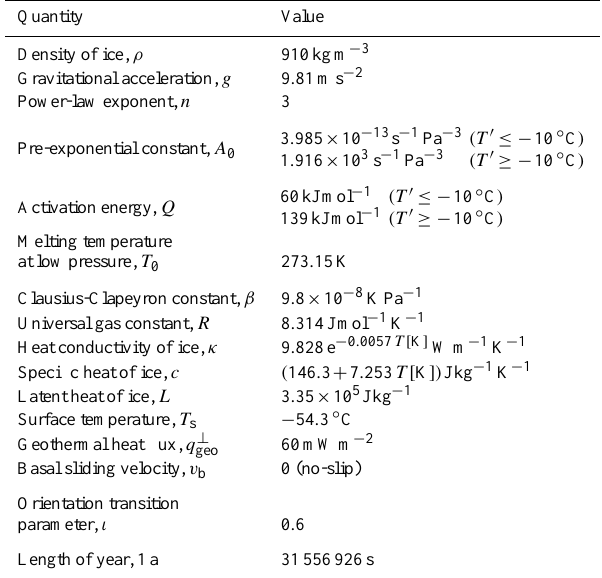
Table 1. Standard physical parameters and boundary conditions used in this